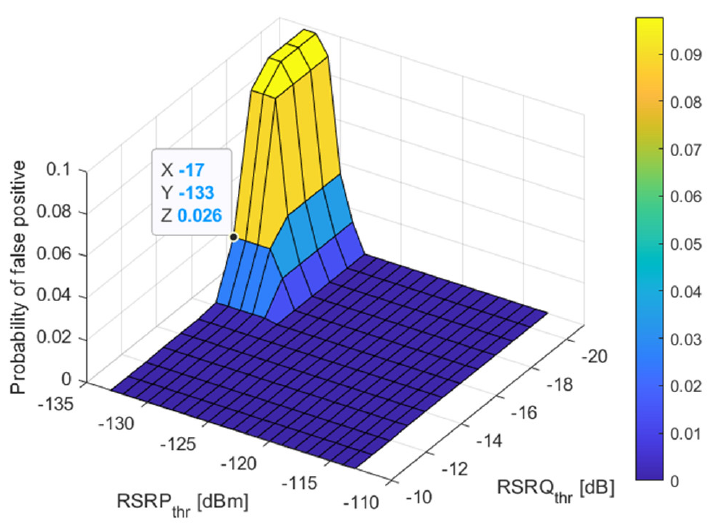
Figure 13. The probability of false positive decision for different threshold values for RSSI and RSRQ while the threshold for RSSI was set to −100 dBm and the threshold for SINR was set to 0 dB.